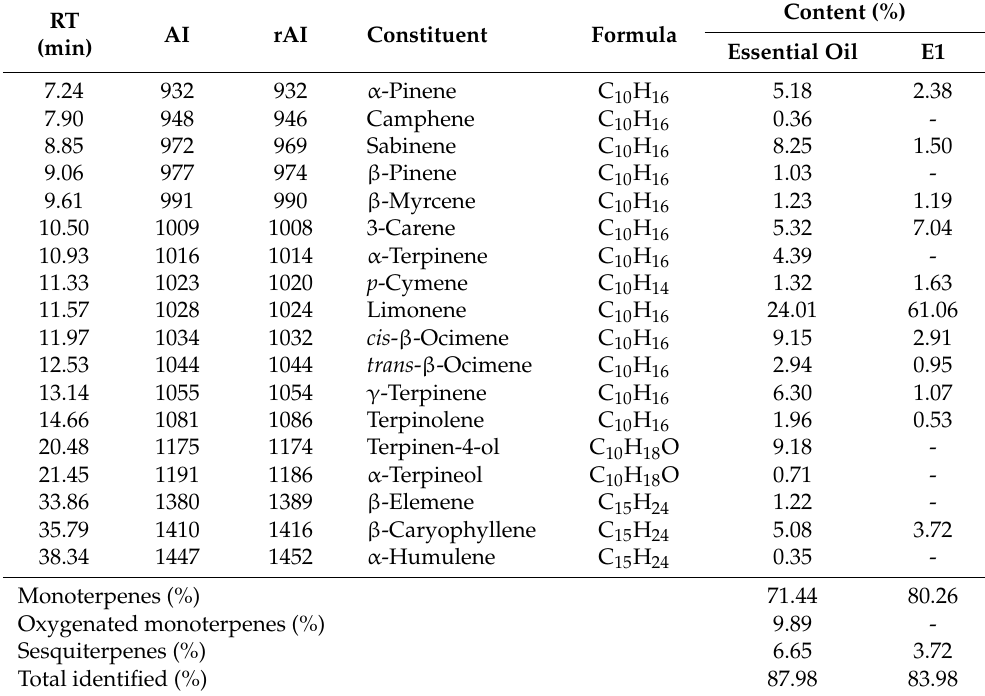
Table 3. Compositions of Pistacia chinensis leaf essential oil and fraction E1.